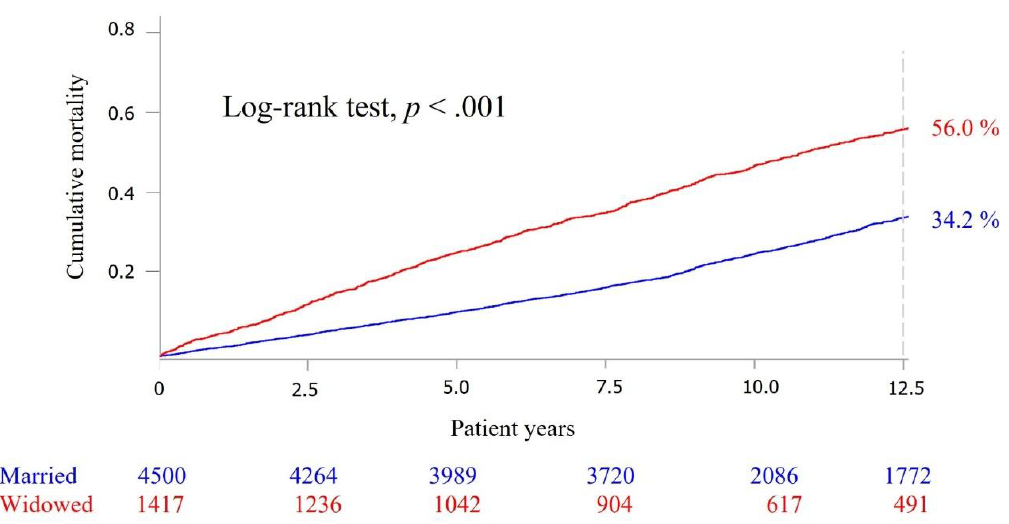
Figure 2. Kaplan–Meier survival curve between the widowed (red line) and nonwidowed (blue line).